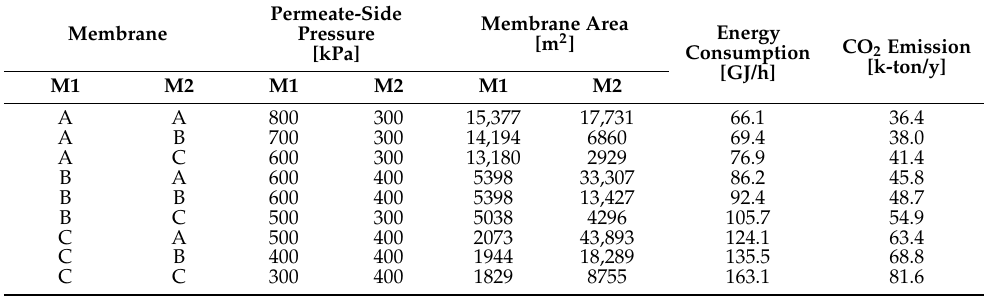
Table A1. Design and operating conditions at minimum energy consumption for the current